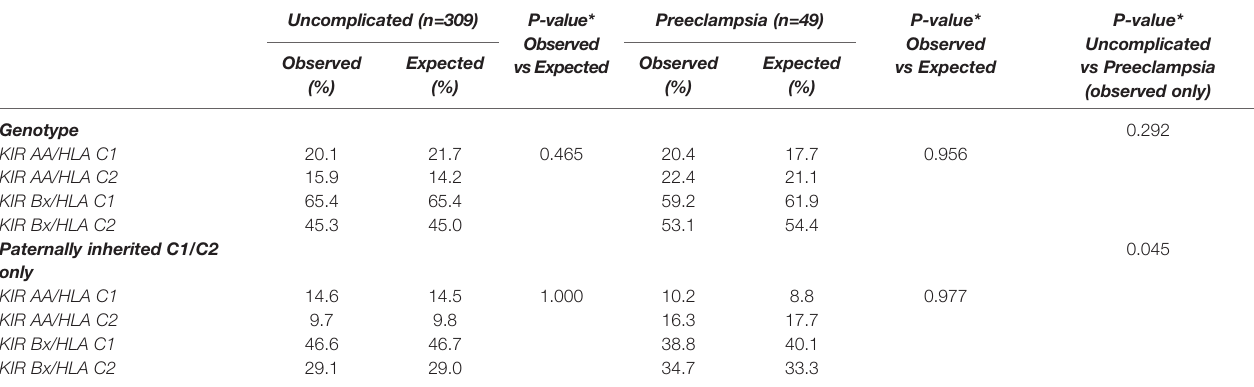
TABLE 3 | Observed and expected-by-chance KIR/HLA-C